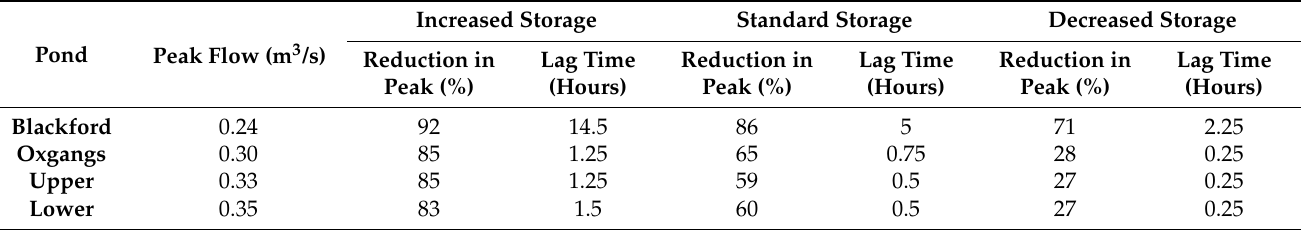
Table 3. The change in flow peak and lag time to the adjacent water course as a result of incorporating the ponds into the model for a 1 in 100 year 1 h